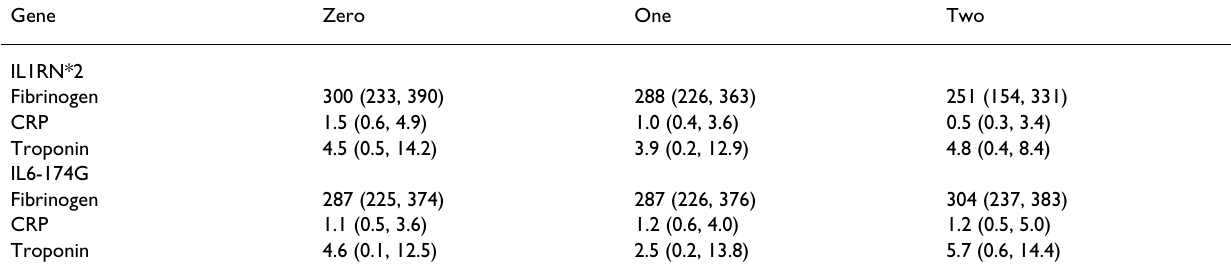
Table 6: OPUS IMI16 study: Median (Q1, Q3) values for fibrinogen, CRP, and Troponin T. Gene